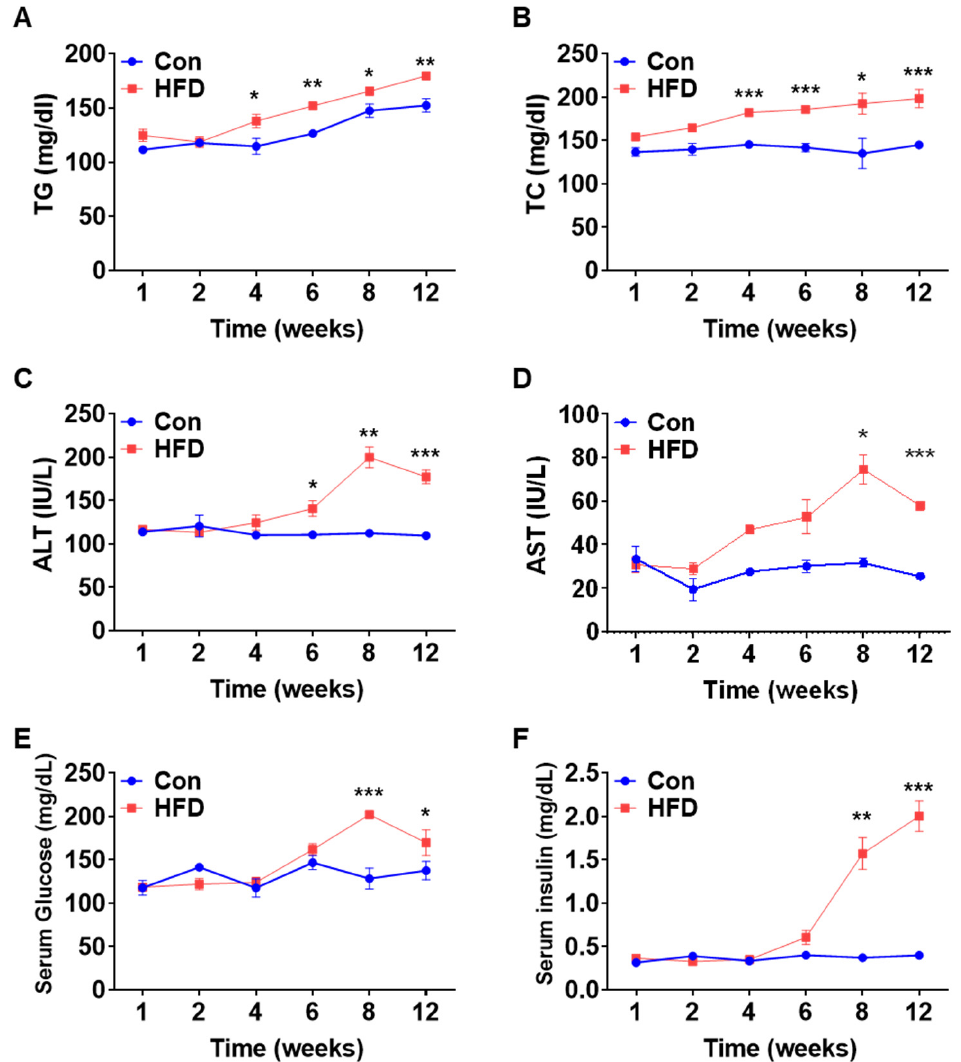
Figure 2. Changes in serum profile. Serum lipids and liver toxicity marker profiling analysis of WT mice after feeding chow diet or HFD for 12 weeks: ( A ) TG, ( B ) TC, ( C ) ALT, ( D ) AST, ( E ) glucose, and ( F ) insulin ( n = 5). * p < 0.05, ** p < 0.01 and *** p < 0.001 Control vs. HFD-fed WT mice of the respective weeks. TG: triglyceride, TC: total cholesterol, ALT: alanine aminotransferase, AST: aspartate aminotransferase, HFD: high-fat diet.